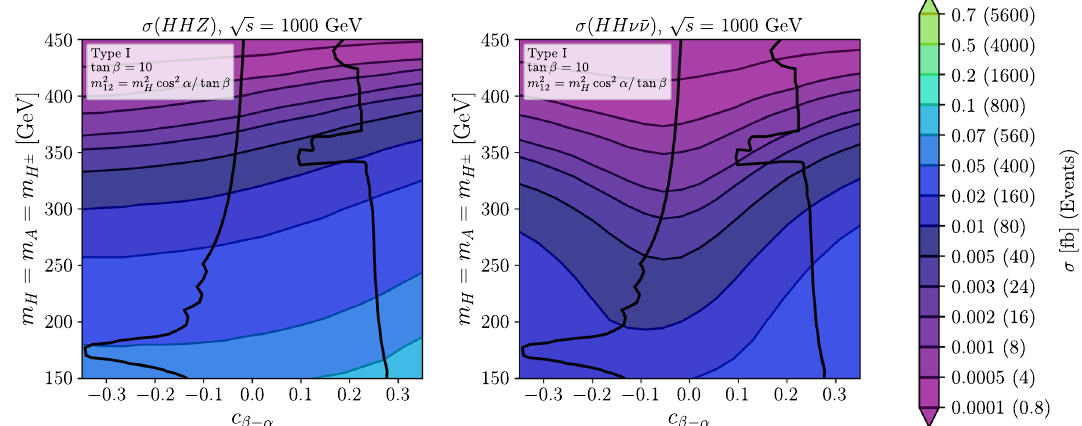
√ s = 1000 GeV for our benchmark plane 3. The total allowed regions is